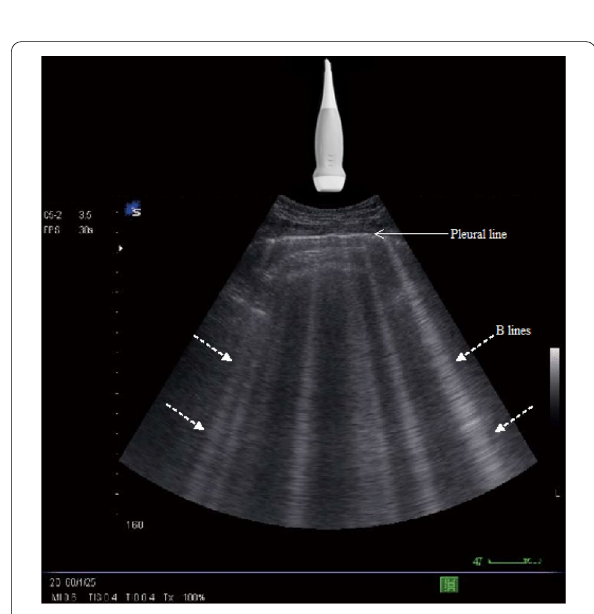
Fig. 2 B-lines represented by vertical hyperechoic images starting from the pleural line and extending to the whole ultrasound field (discontinuous